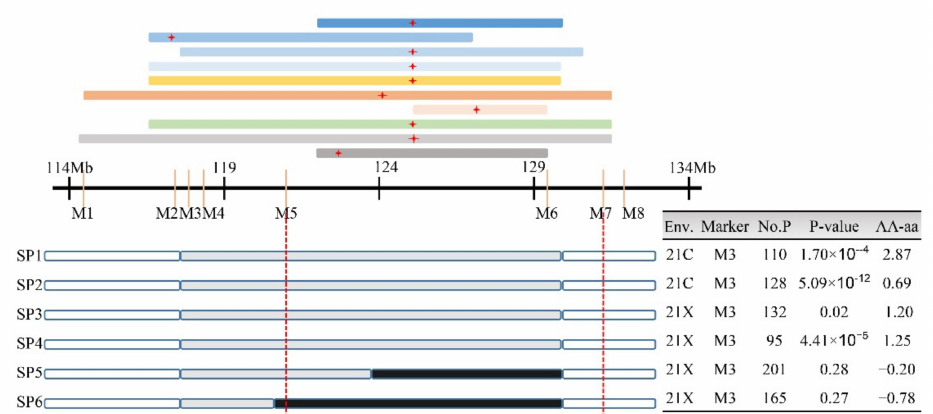
Figure 5. Validation and fine-mapping of qSD9-2 based on recombinant progeny. QTLs located in this region are represented by colored rectangles above the axis, with red “+” representing the peak of the corresponding QTL. The genetic structure of each recombinant is shown below the axis: SP1-SP6, six recombinants selected from the residual heterozygous line (RHL); white, gray, and black rectangles correspond to homozygous YS501, heterozygous YS501/LDC-1, and homozygous LDC-1 alleles, respectively; Env., environment; Marker, genotype information used for one-way ANOVA; No.P, number of individuals in the secondary population; AA-aa, average SD with YS501 allele–average SD with LDC-1